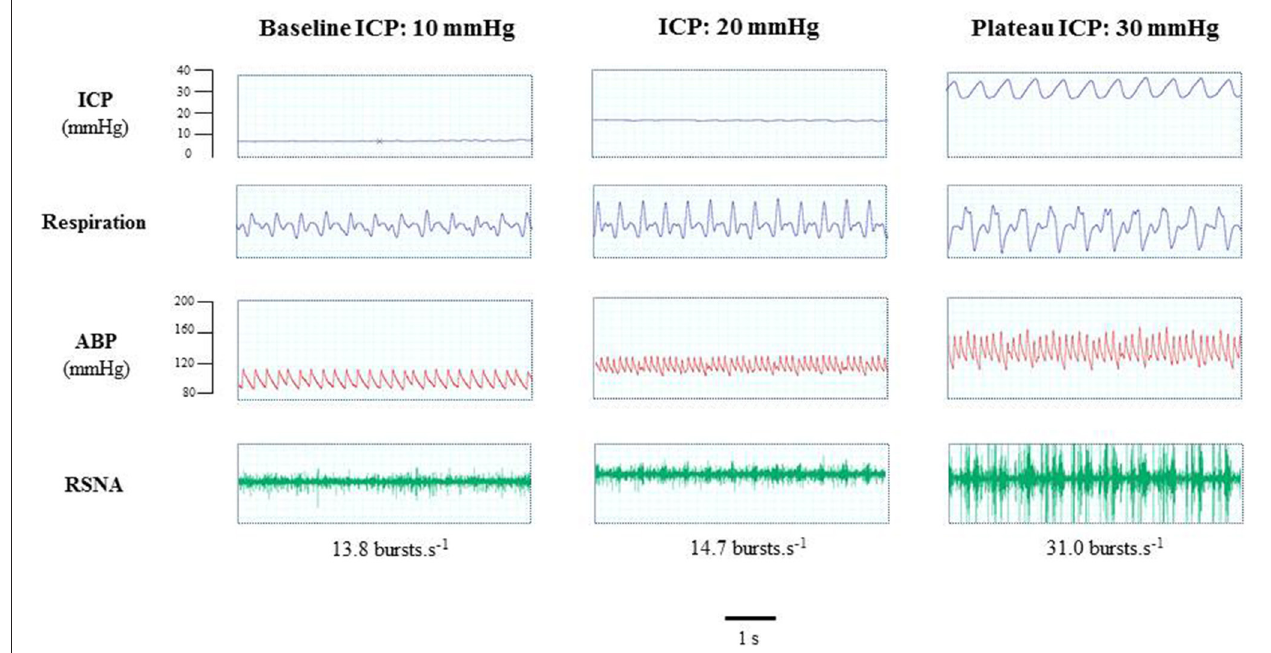
FIGURE 2 | Example of a mouse recording with raw signals of ICP, respiration, ABP and sympathetic activity during modest ICP rise. Example of a mouse raw signal of ICP, respiration, ABP and neurogram of RSNA at baseline ICP ( ≈ 10 mmHg), ICP ( ≈ 20 mmHg) and plateau ICP ( ≈ 30mmHg).